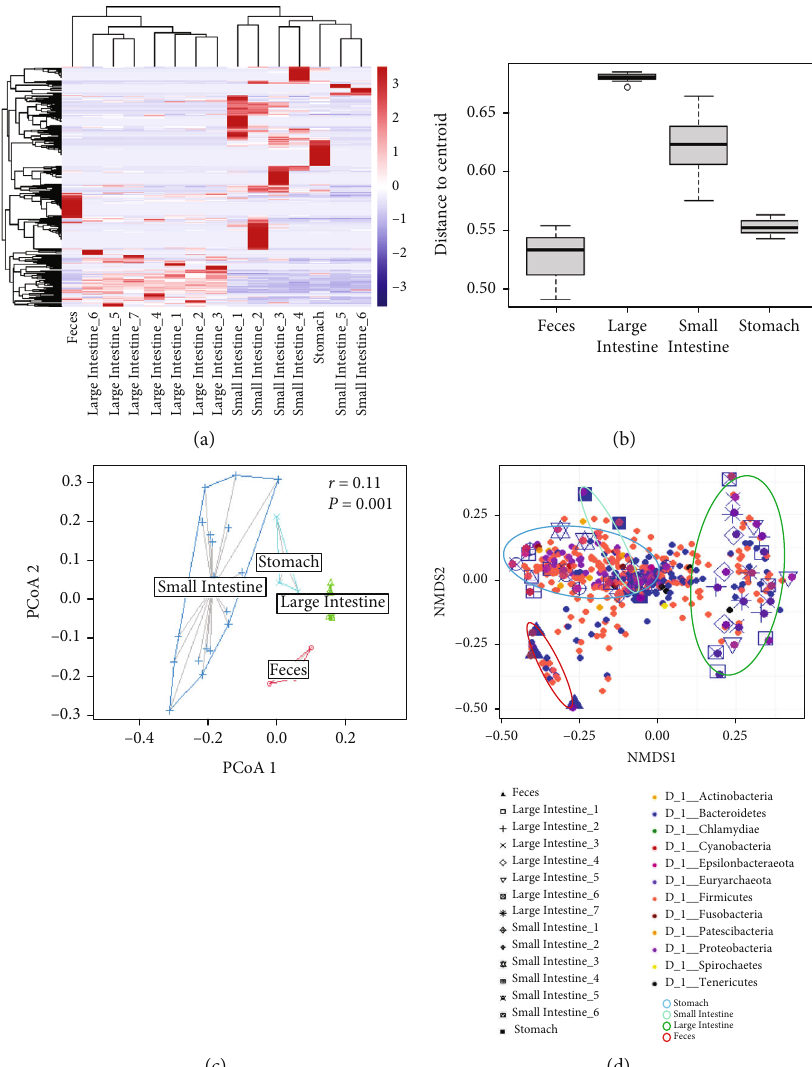
Figure 4: The comparison of microbial diversity at di ff erent locations of the GI tracts by β -diversity analysis. (a) Heatmap of the microbial composition and relative abundance in each location of the GI tracts at the genus level based on the Bray-Curtis distance matrix. (b) β - diversity centroid for each GI site. (c) Principal coordinate analysis ( R 2 = 0 : 11 and P = 0 : 001 ). (d) NMDS plots show the di ff erence of microbiome in each location of the GI tracts. The sampling locations within the GI tract were determined based on the anatomical feature: the stomach, the duodenum (small intestine_1), the jejunum (small intestine_2 ~ small intestine_5), the ileum (small intestine_ 6), the cecum (large intestine_1), the colon (large intestine_2 ~ large intestine_6), and the rectum (large intestine_7). The anatomical di ff erences between each location are shown in Figure